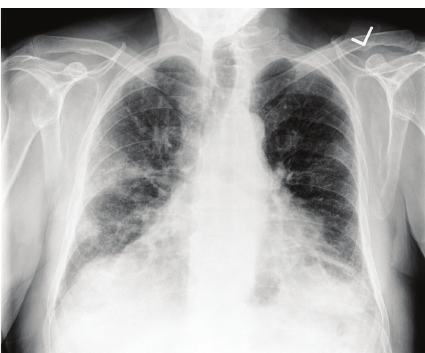
Figure 1: Chest X-ray 5-6 weeks before admission showing bilateral patchy lung opacities.